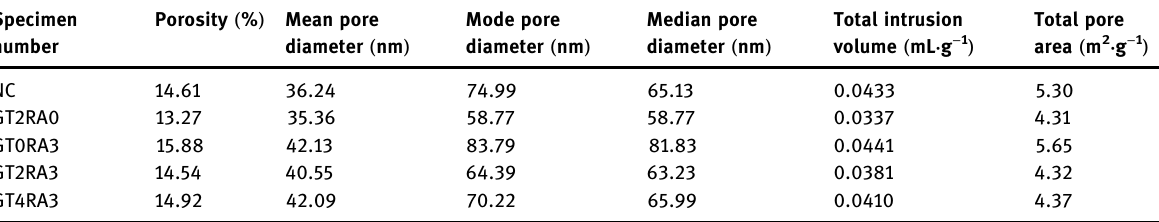
Table 6: Porosity, summary of pore size statistics, total pore size, and area Specimen